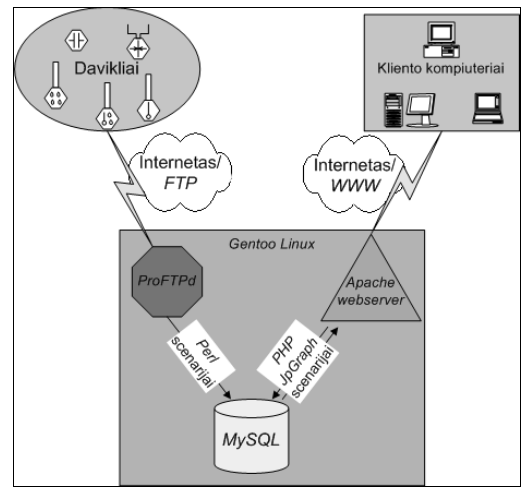
Fig 6 . Fragment of Perl script for calculation of maximum